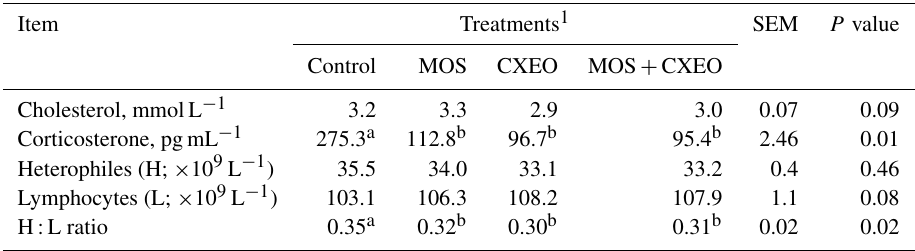
Table 4. Effect of mannan oligosaccharide (MOS) and Curcuma xanthorrhiza essential oil (CXEO) on stress indicators in broilers subjected to heat